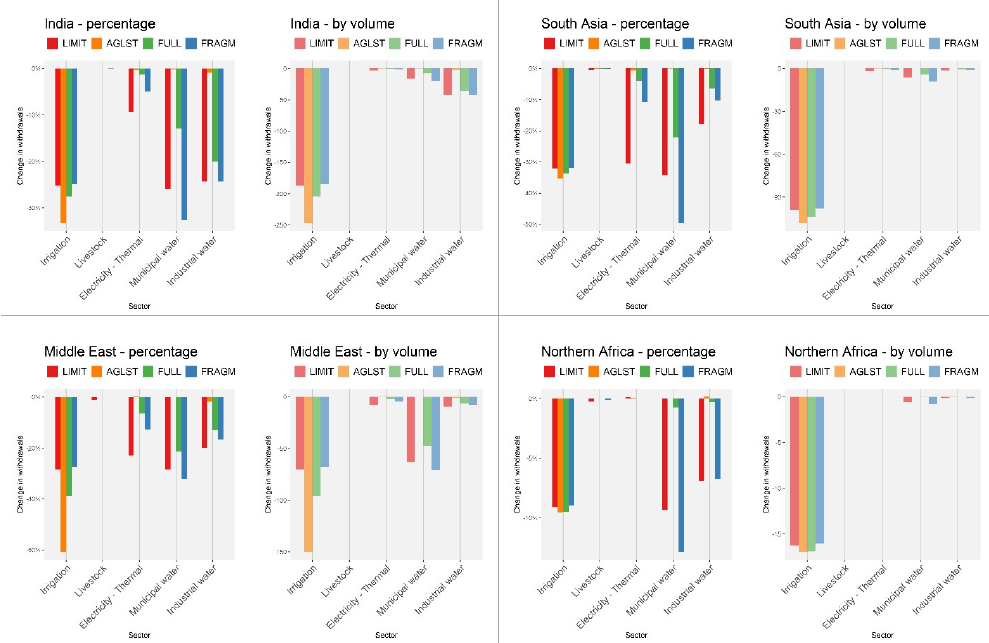
Figure 6. Withdrawal changes by region and by self‐abstracting sector in relative and absolute terms.